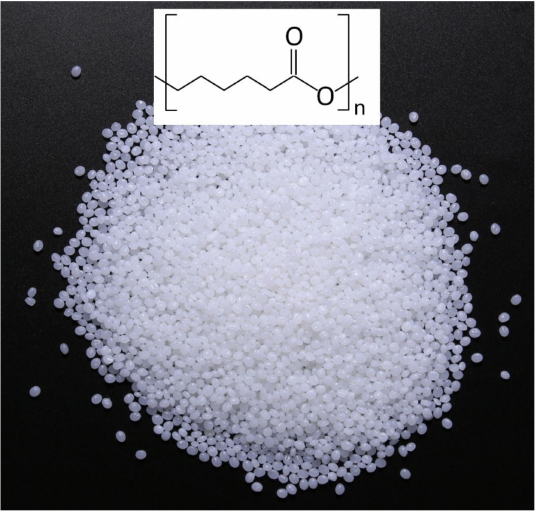
Figure 2. Polycaprolactone is a biodegradable polyester and ideal material for preparation of electrospun